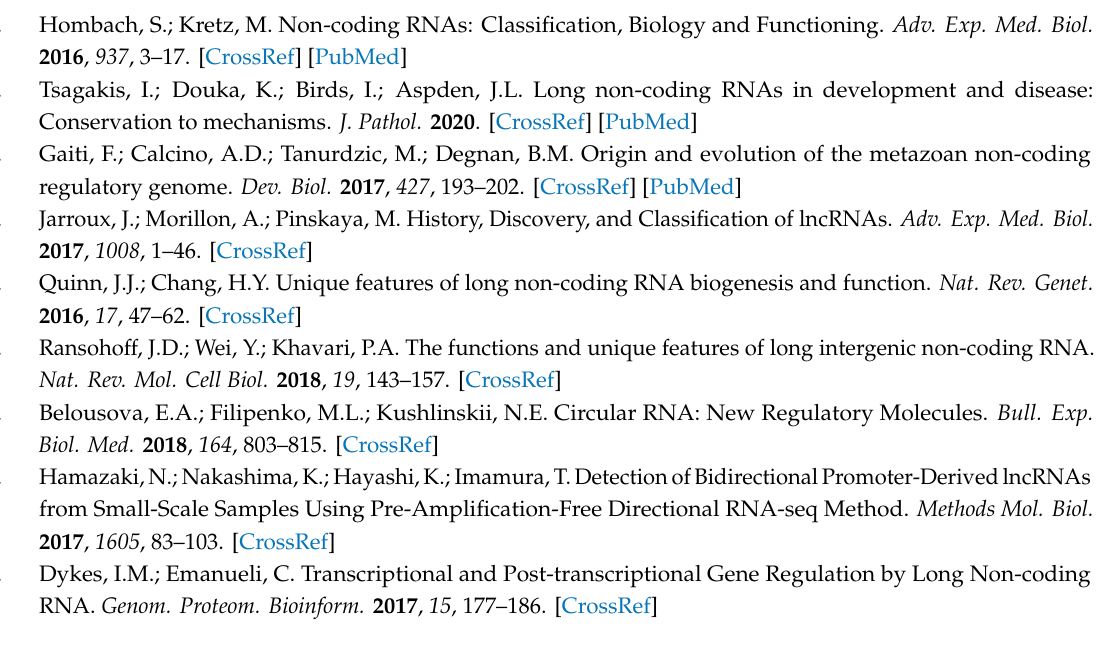
Figure S1: qRT-PCR selected lncRNAs stability results. The funnel chart shows the ranking of analyzed lncRNAs stability, obtained from the geometric mean of rankings values computed by Delta CT, GeNorm, NormFinder and BestKeeper algorithms. The lower stability value corresponds to more stably expressed gene., Table S1: RNA-Seq analysis on the gene level, Table S2: RNA-Seq di ff erential expression analysis of the most dysregulated lncRNAs, Table S3: Annotation enrichment of most dysregulated lncRNAs, Table S4: Fold change expression of selected lncRNAs after A2E treatment, calculated by ∆∆ Ct method, Table S5: RNAInteractor Database analysis of lncRNAs, Table S6: ClueGo pathway analysis of most dysregulated lncRNAs, Table S7: mirPath analysis of miRNAs sponged by most dysregulated